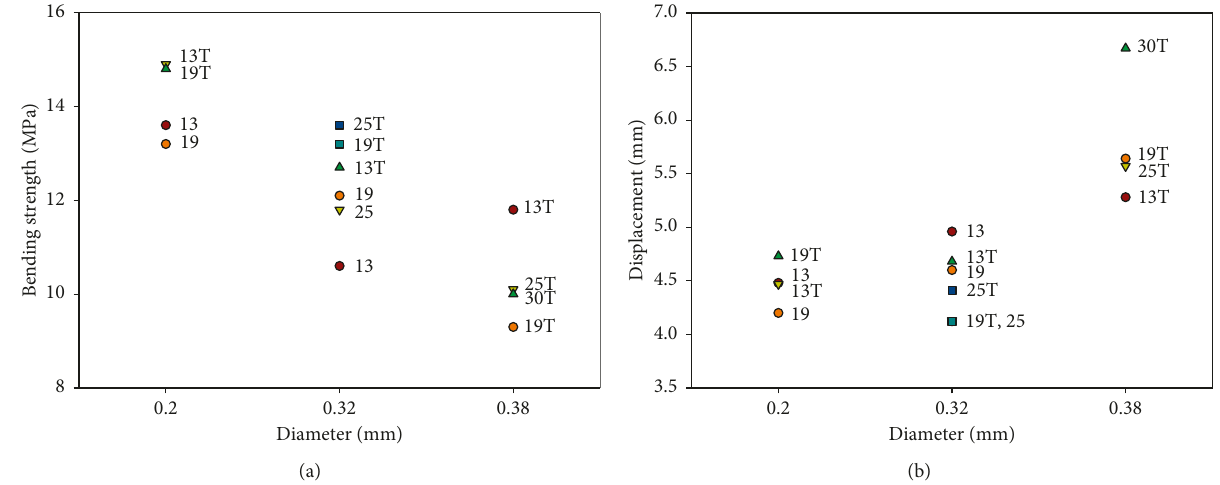
Figure 10: Bending strength and displacement according to fiber diameter.